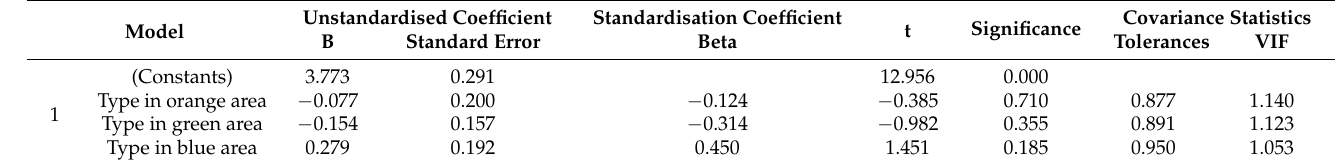
Table 5. Parameter estimation.